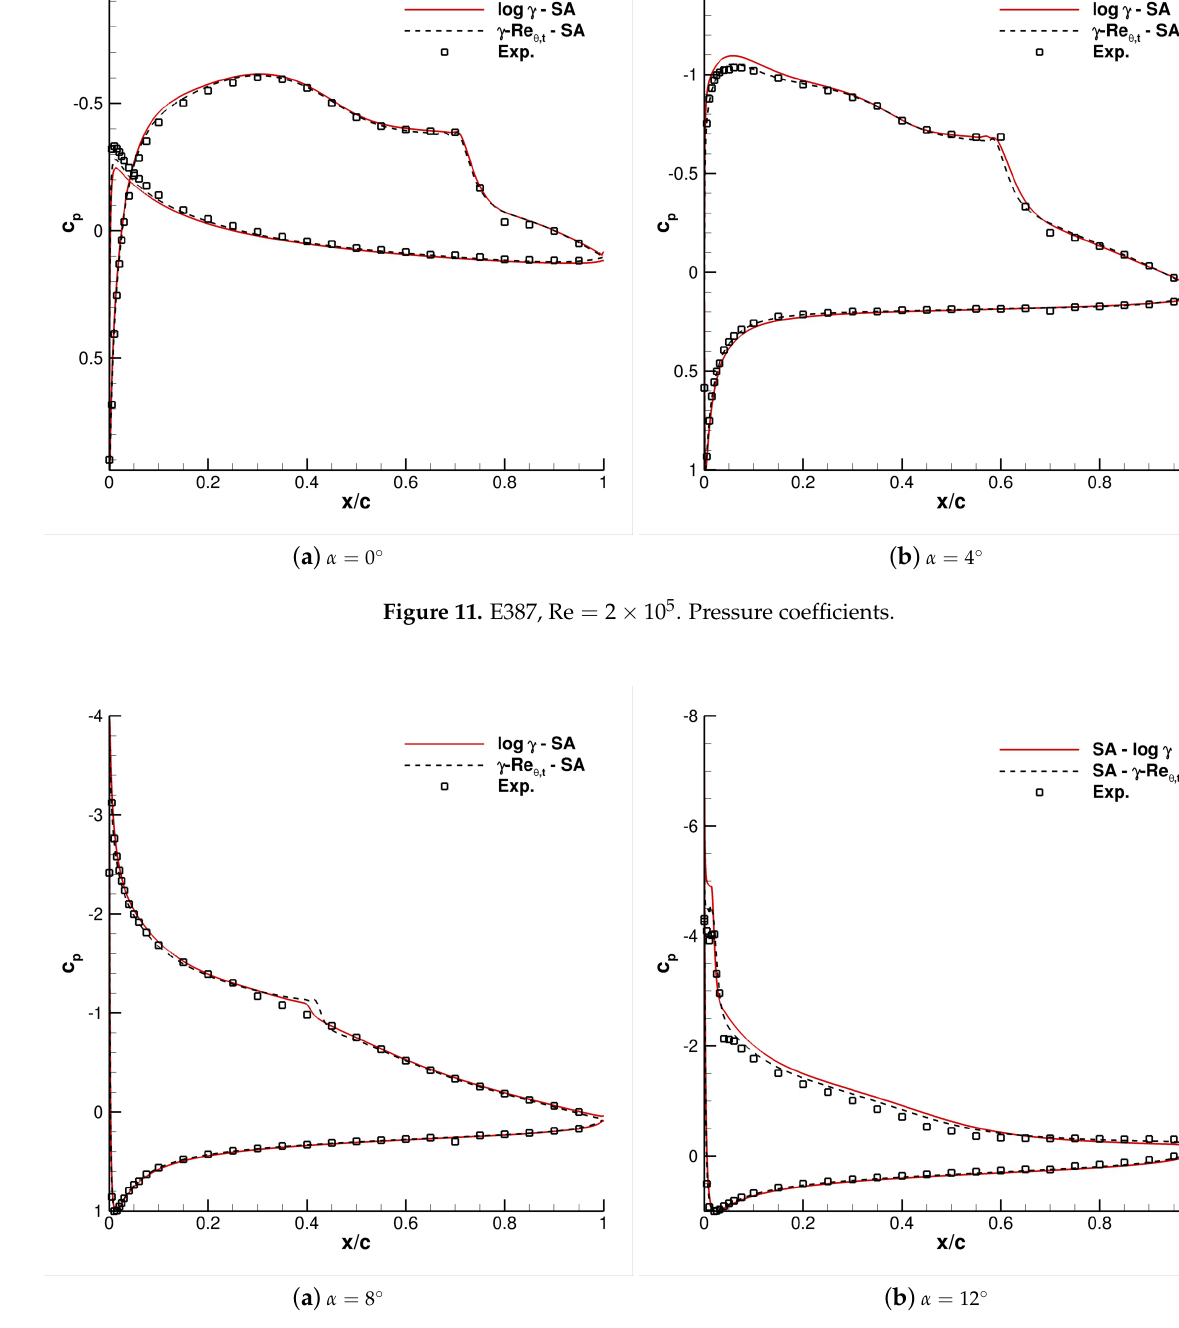
Figure 12. E387, Re = 2 × 10 5 . Pressure